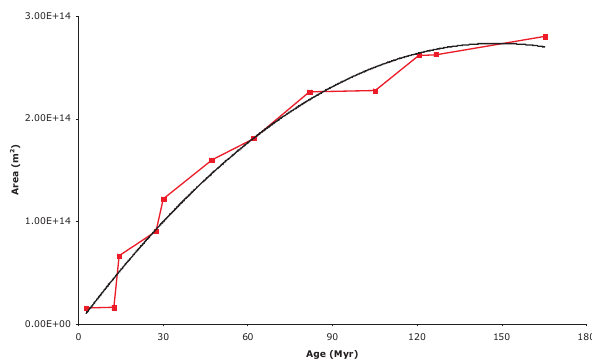
Fig. 13. Cumulative area of oceanic crust (m 2 ) as a function of age (Ma). A least squares fit through the data for Eq. (3) is shown as a dark curve. We note that the data are reasonably well fit by such an expression, as pointed out originally by Sclater et al.